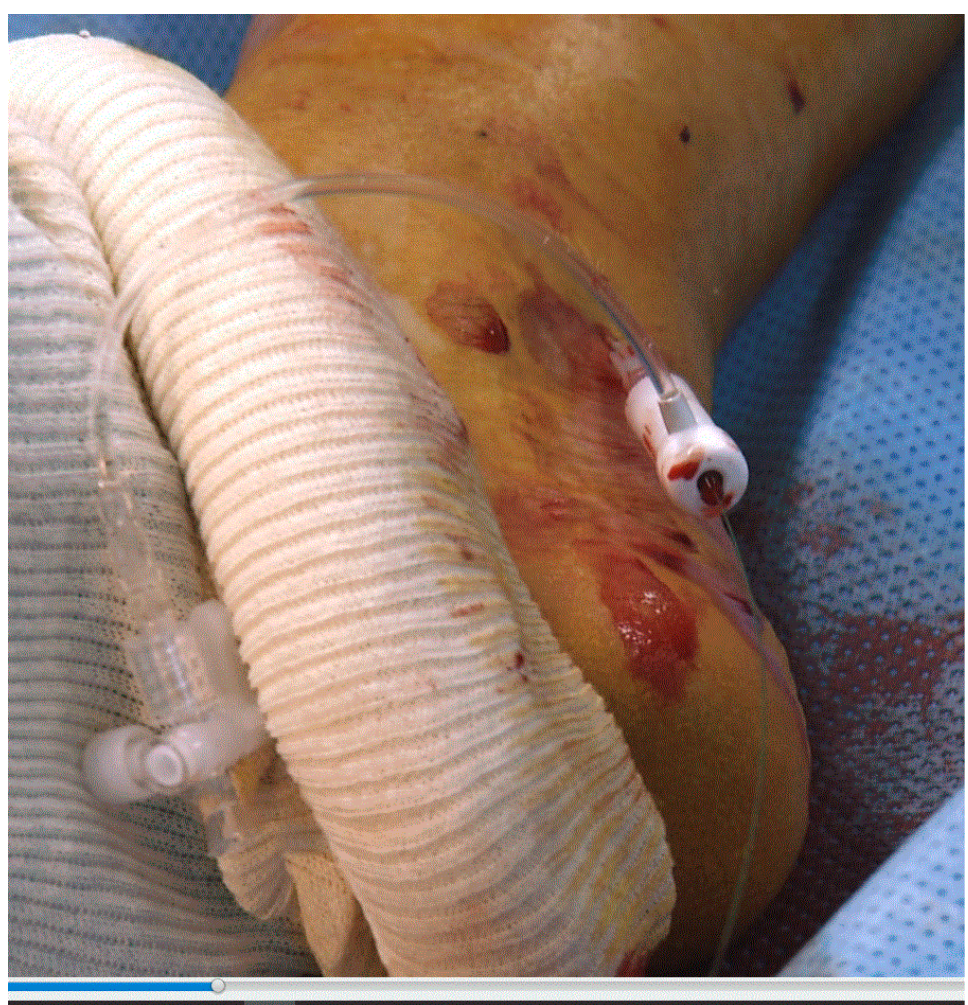
Figure 2. Contralateral posterior tibial artery puncture.